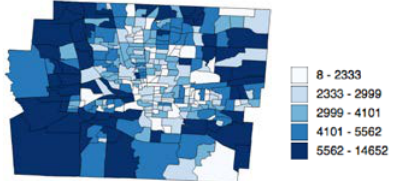
Figure 4. Total population of the official census tracts.